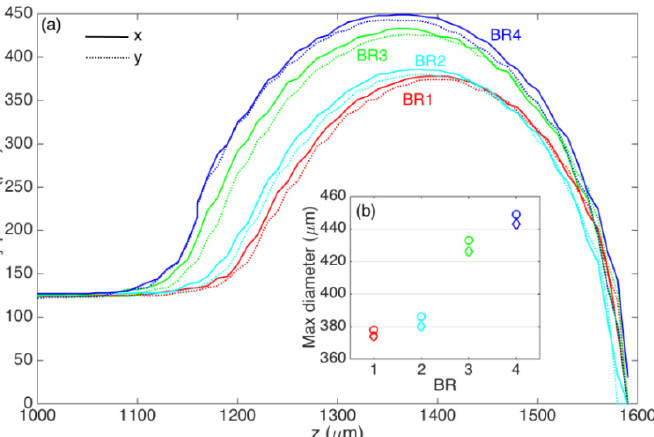
Figure 1. Profilometry of the four ball resonators fabricated with the CO 2 laser splicer. ( a ) Profilometry chart, reporting the local diameter along x (solid lines) and y (dotted lines) along the fiber direction z, for each ball resonator BR1 (red), BR2 (cyan), BR3 (green), and BR4 (blue). ( b ) Maximum diameter for each ball resonator, evaluated along x (circles) and y (diamonds).